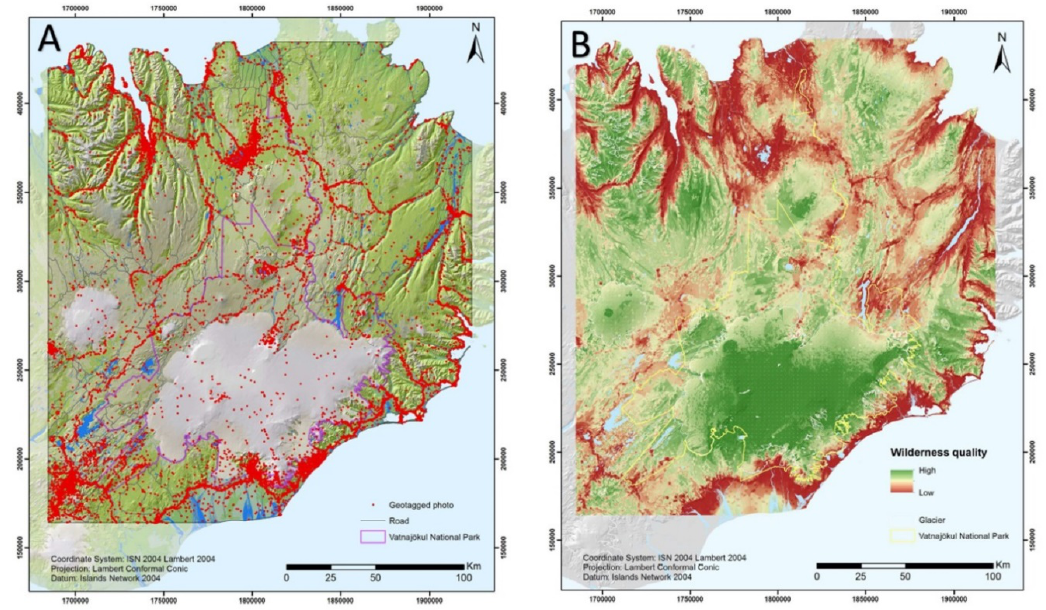
Figure 3. ( A ) The distribution of web-shared geotagged photographs taken by tourists in the eastern part of Iceland. ( B ) Wilderness map over the same area. Vatnajökull National Park is delineated by a yellow line [27].